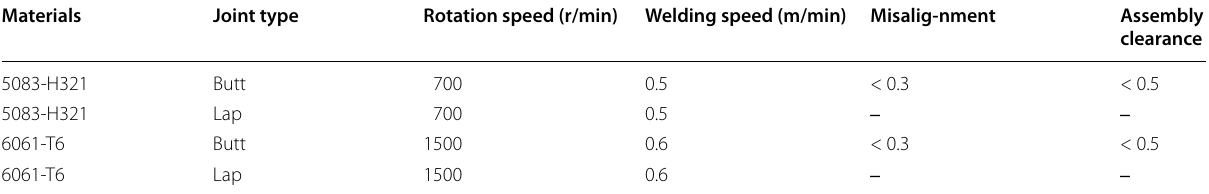
Table 1 Parameters of friction stir welding